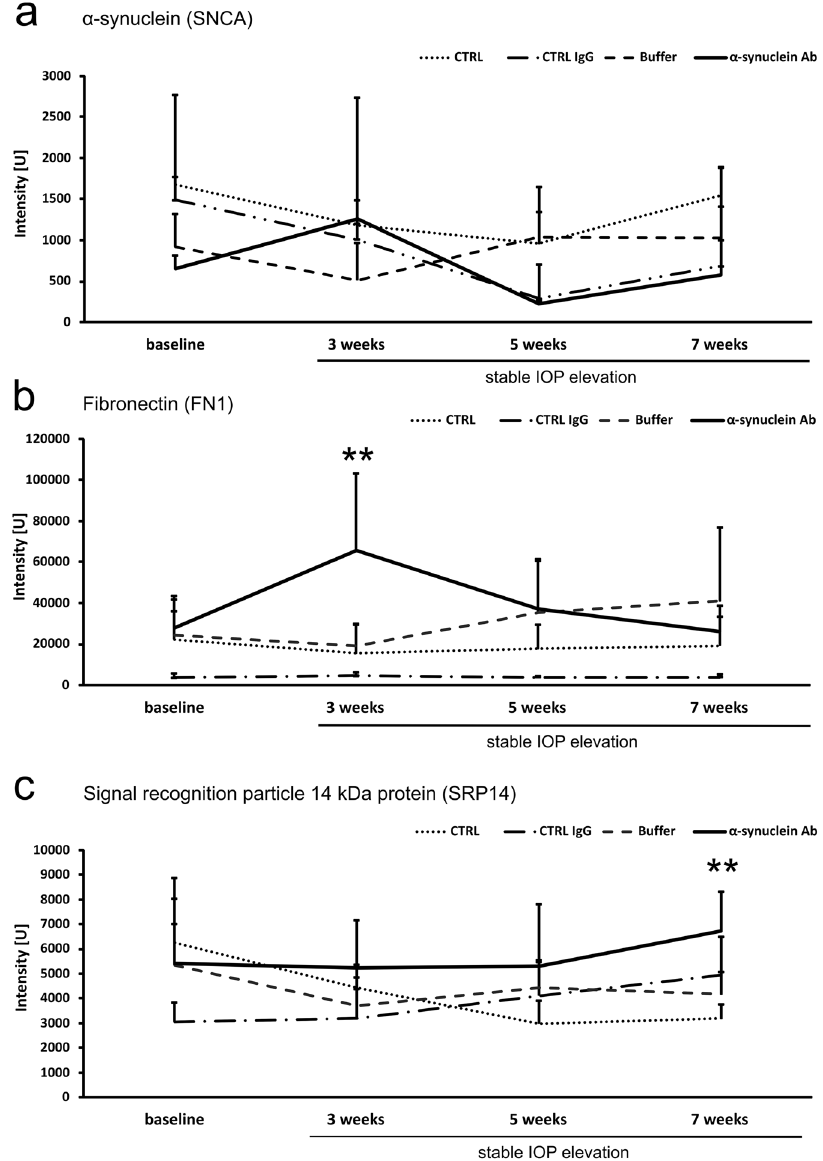
Figure 7. Follow-up of the immunoreactivities of antibodies to α -synuclein, fibronectin and signal recognition particle 14 kDa protein. Quantification of antigen reactivities of control (CTRL,dotted line), CTRL IgG (dash/dotted line), Buffer (hatched line) and α -synuclein injected ( α -synuclein Ab, continuous black line) animals at baseline, and 3, 5, and 7 weeks after stable IOP elevation. ( a ) The α -synuclein (SNCA) antigen-Ab immunoreactivities are plotted and show no significant changes for CTRL, CTRL IgG, Buffer and α -synuclein Ab group over time. ( b ) Fibronectin (FN1) is a major surface glycoprotein that has been shown to interact with intracellular actin filament bundels. Compared to all three control groups, α -synuclein Ab group show significantly elevated immunoreactivities three weeks after stable IOP elevation ( ** , all p < 0.001) with a decrease to baseline levels after 5 and 7 weeks. ( c ) The signal recognition particle 14 kDa protein (SRP14) is plotted. At the end of the study, immunoreactivities of the α -synuclein Ab group were significantly increased compared with CTRL and Buffer group ( ** p <